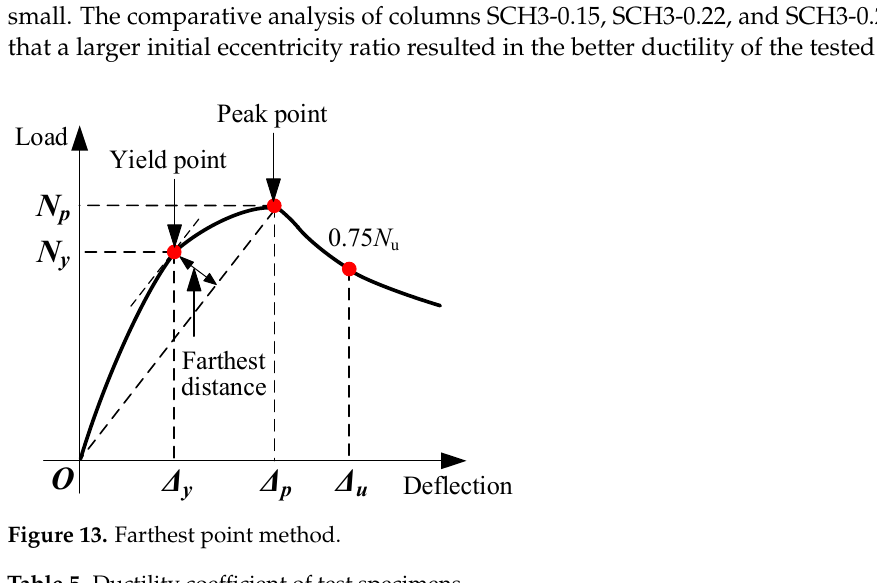
Table 5. Ductility coefficient of test specimens.